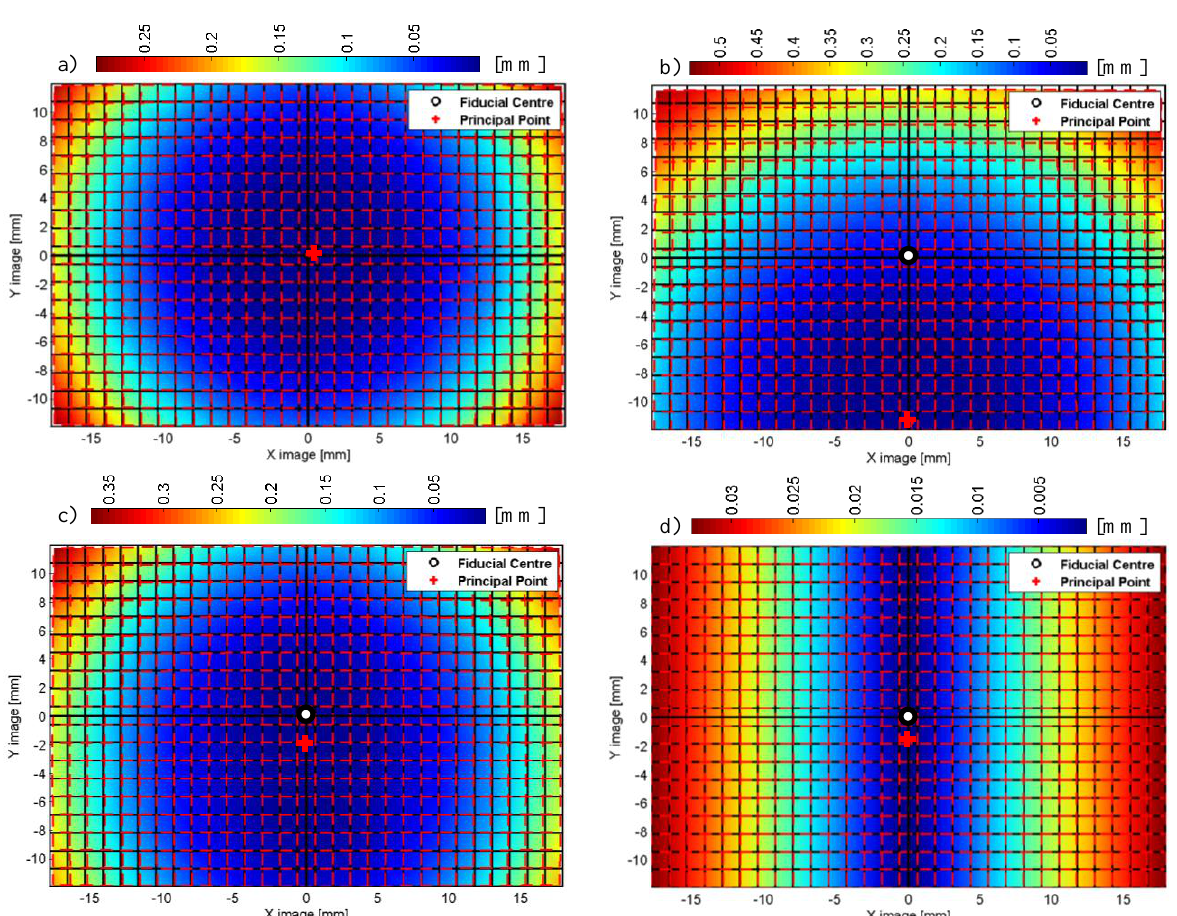
Figure 6. Distortion maps (difference in mm between ideal and actual distorted pixel position): a) D750-45mm T0S0R0 , b) D750-45mm T0S11R0 , c) D750-45mm T-4S0R90, d) only the effect of the affinity correction for D750-45mm